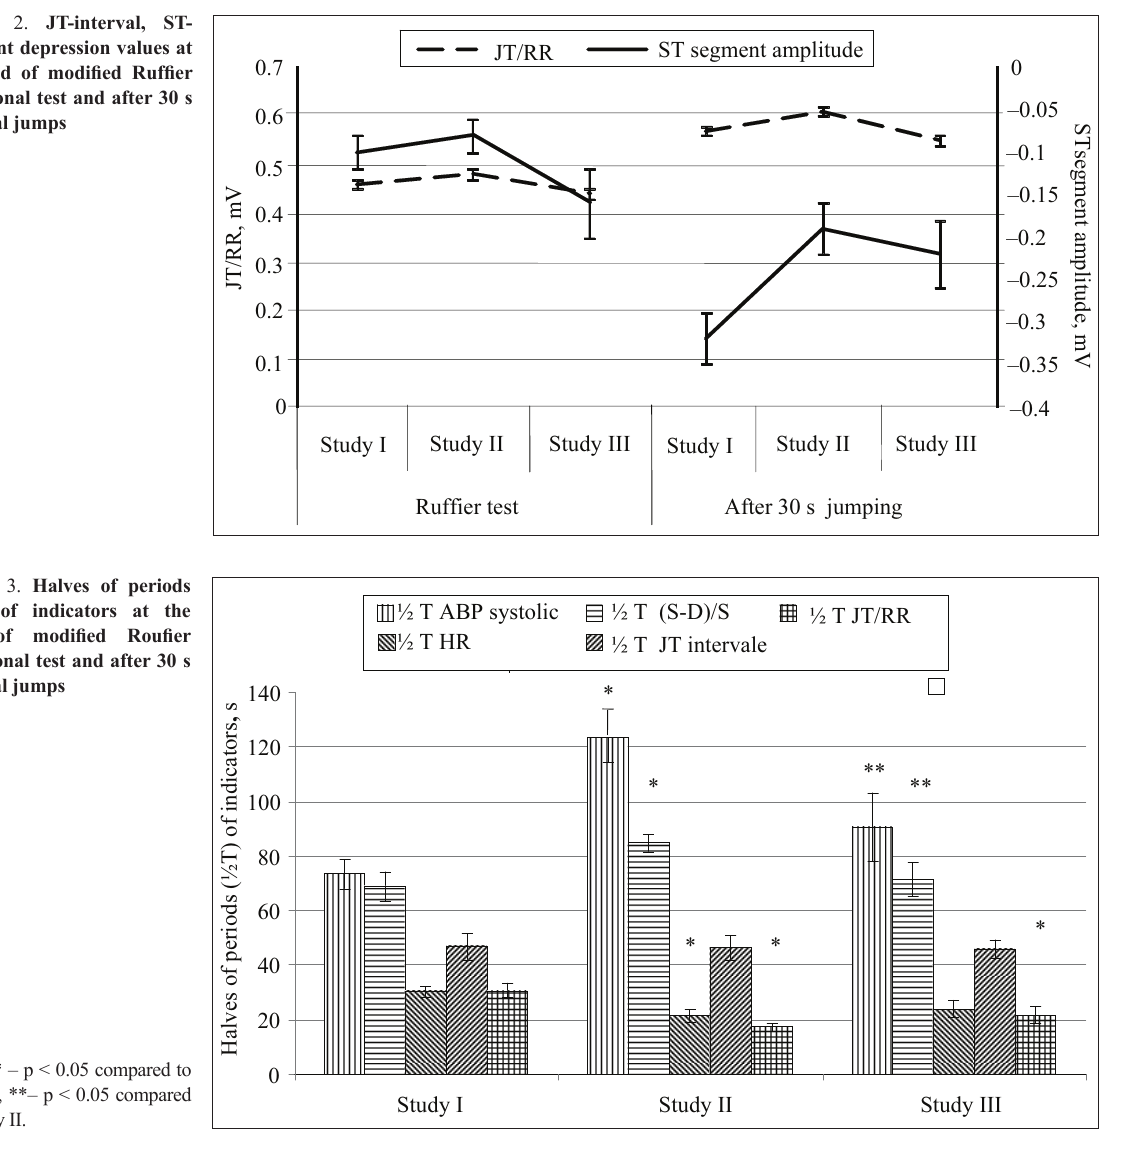
Figure 3. Halves of periods (½T) of indicators at the end of modified Roufier functional test and after 30 s vertical jumps